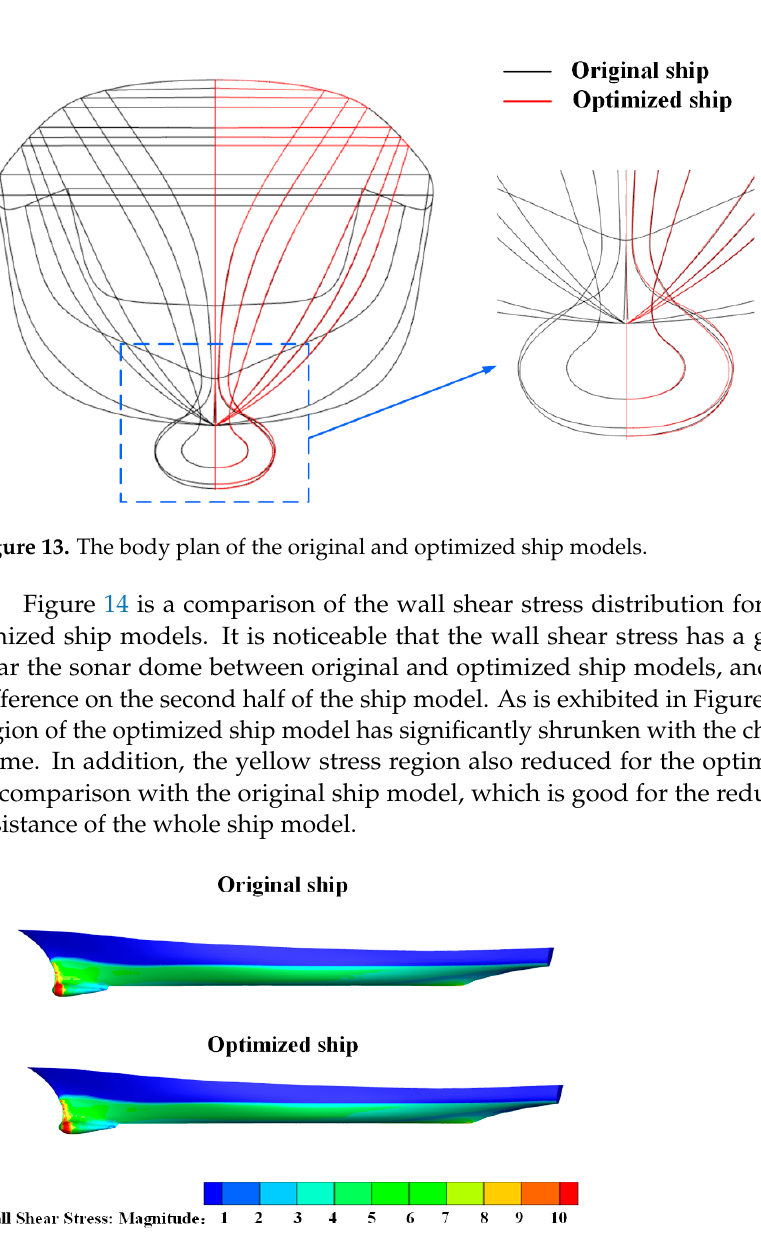
Figure 14. The wall shear stress distribution for different ships.